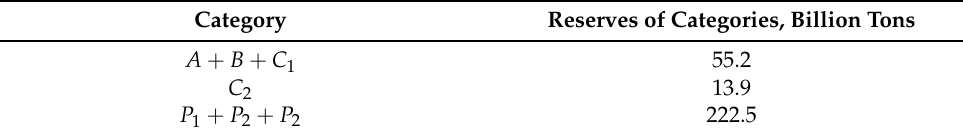
Table 2. Distribution of coal